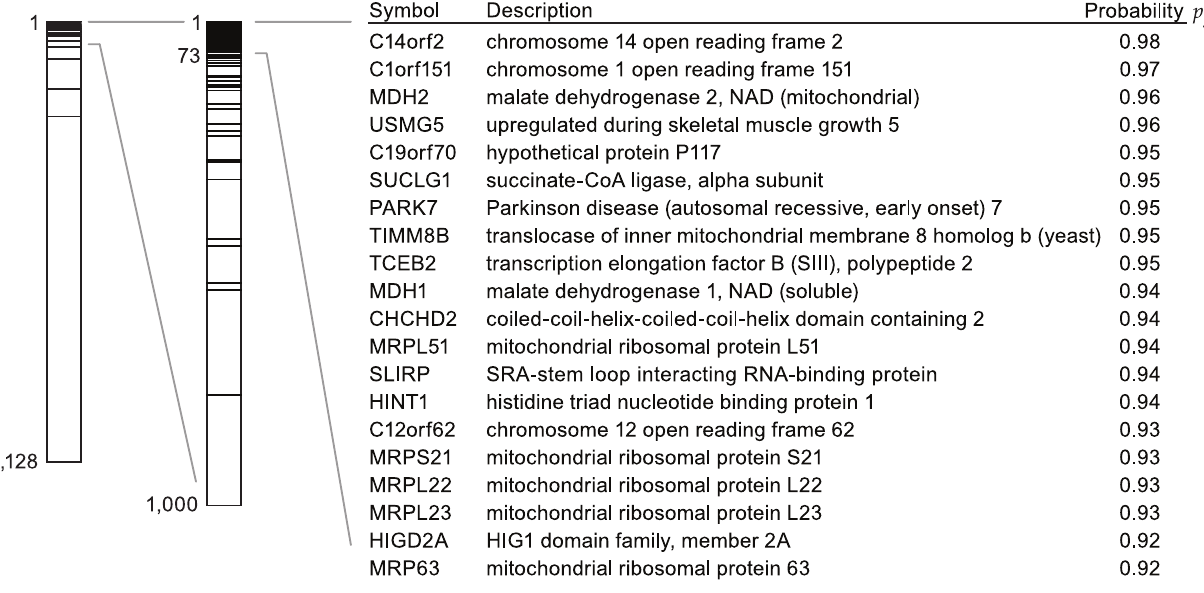
Figure 3. Top scoring genes in the OxPhos expression screen. Left, bar plot indicating the ranks of each OxPhos query gene by descending probability p g , as well as a magnified view of the 1,000 highest-ranking genes. The table displays the top 20 non-OxPhos genes resulting from the expression screen (corresponding to the top 73 genes including OxPhos).